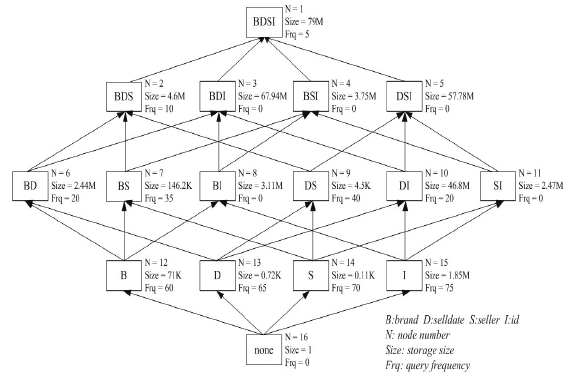
Fig. 3. The iterative processes of AGA and GA algorithms 6.